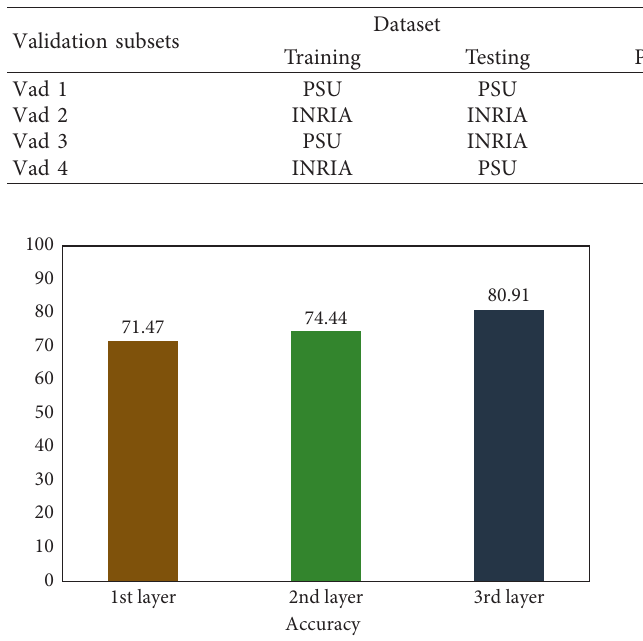
Figure 7: Example of images for training and testing samples from the INRIA person dataset and PSU dataset. Table 3: Total number of sample data for the validation data.